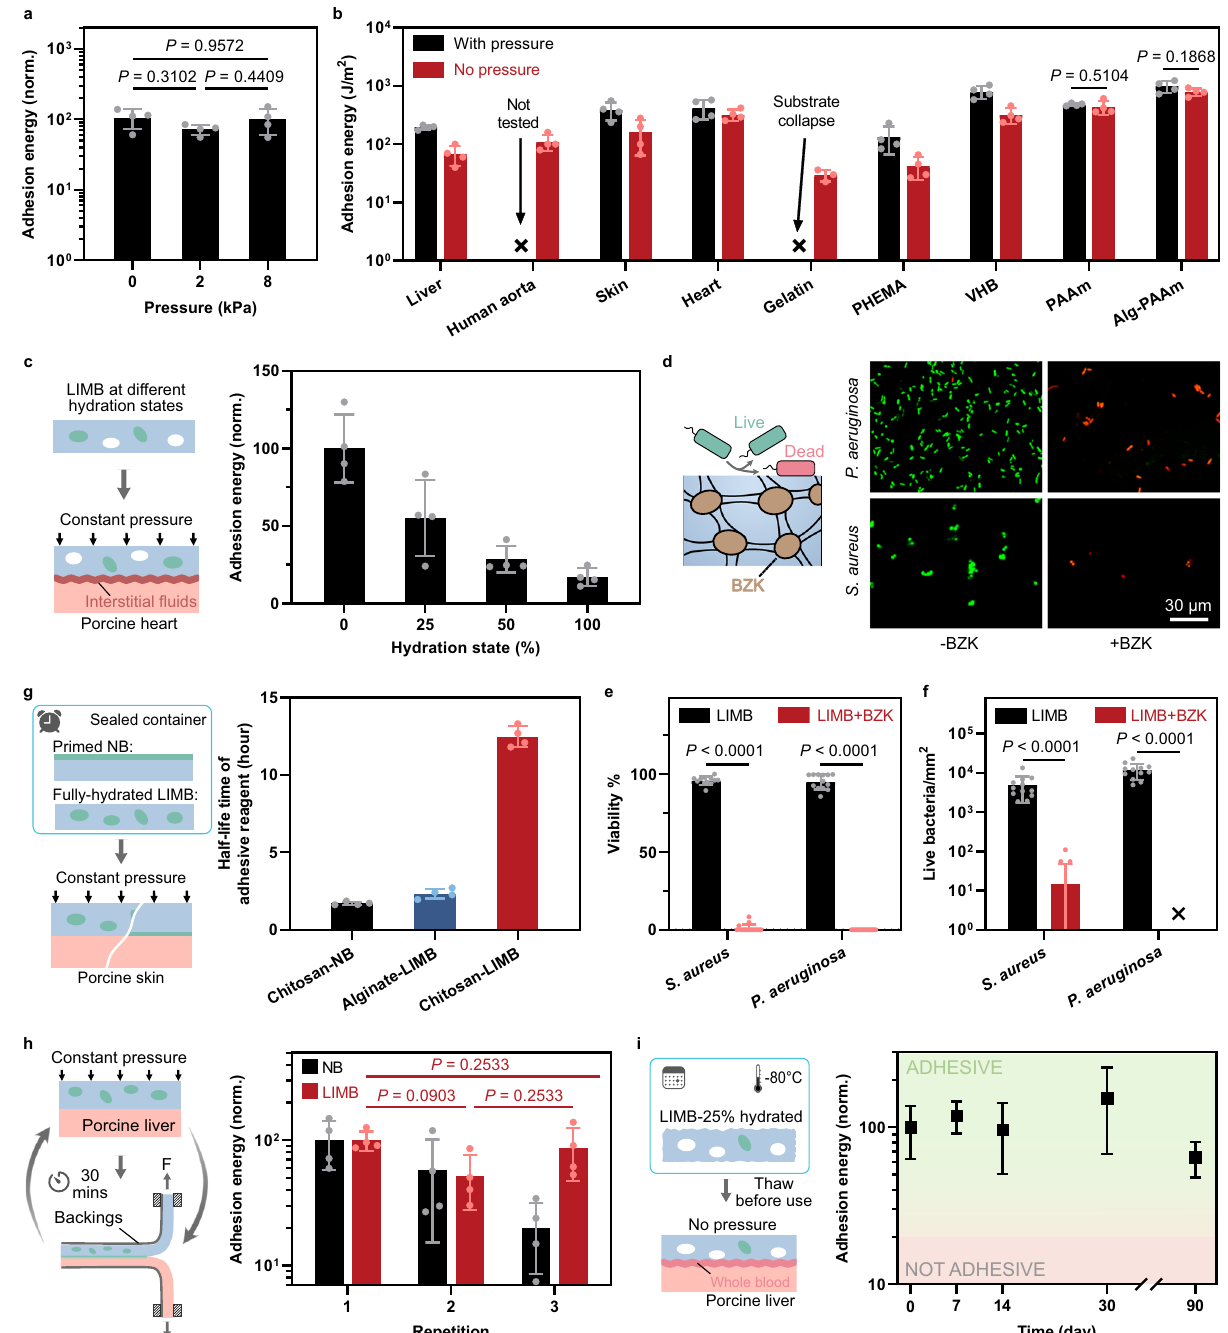
Fig. 3| Pressure-insensitiveadhesionand effectsofinfusedliquidonadhesion, antibacterial function, and usability. a LIMB is pressure-insensitive at a low- pressure range. b Adhesion performance on diverse substrates with and without applying pressure (~60kPa) to form initial adhesion. The adhesion on the human aorta with pressure was not measured due to the unavailability of tissue samples. c Adhesionenergyasafunctionofhydrationstate. d Benzalkoniumchloride(BZK) as an antimicrobial functional liquid can enable LIMB with antimicrobial function, asevidencedbytheLIVE/DEADassayson P.aeruginosa and S.aureus . e Viabilityand